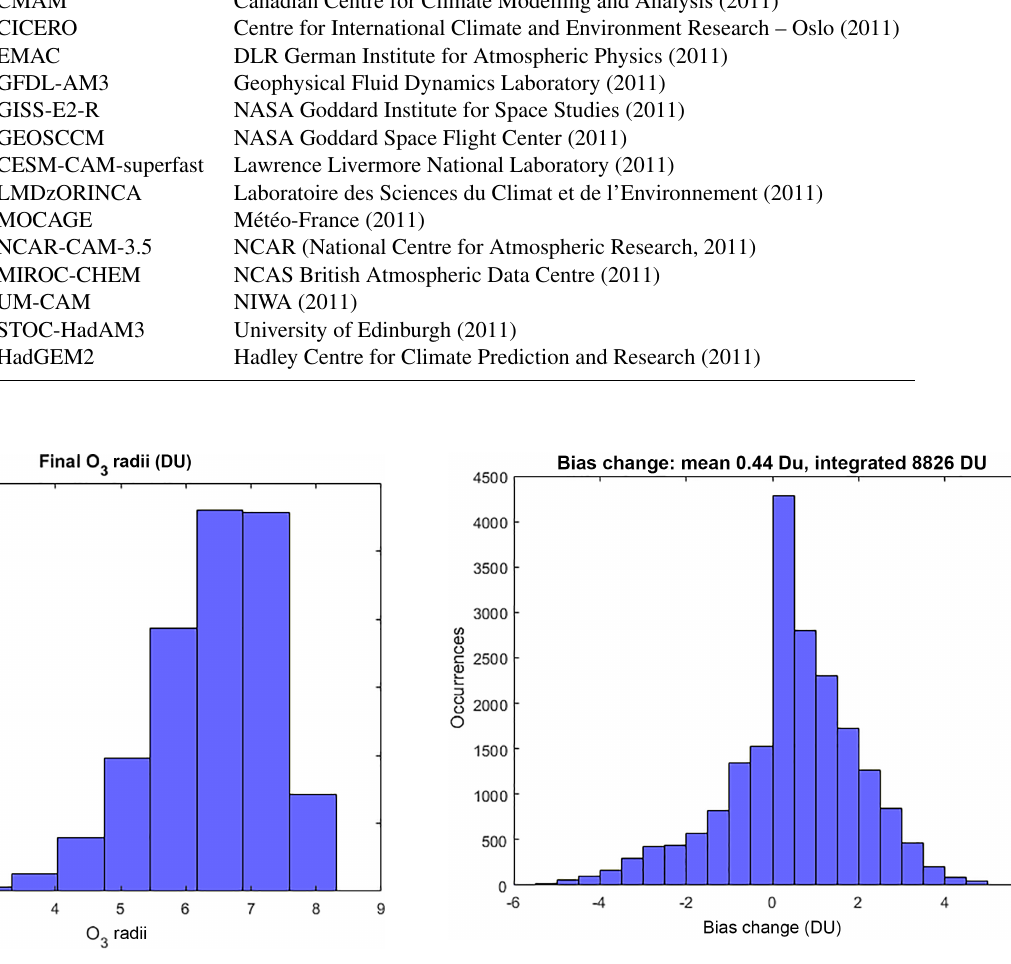
Figure A2. Magnitude of the difference between annually inte- grated model–observation ozone biases (DU) calculated using a cluster-based MMM and a simple, all-model MMM (see Sect.